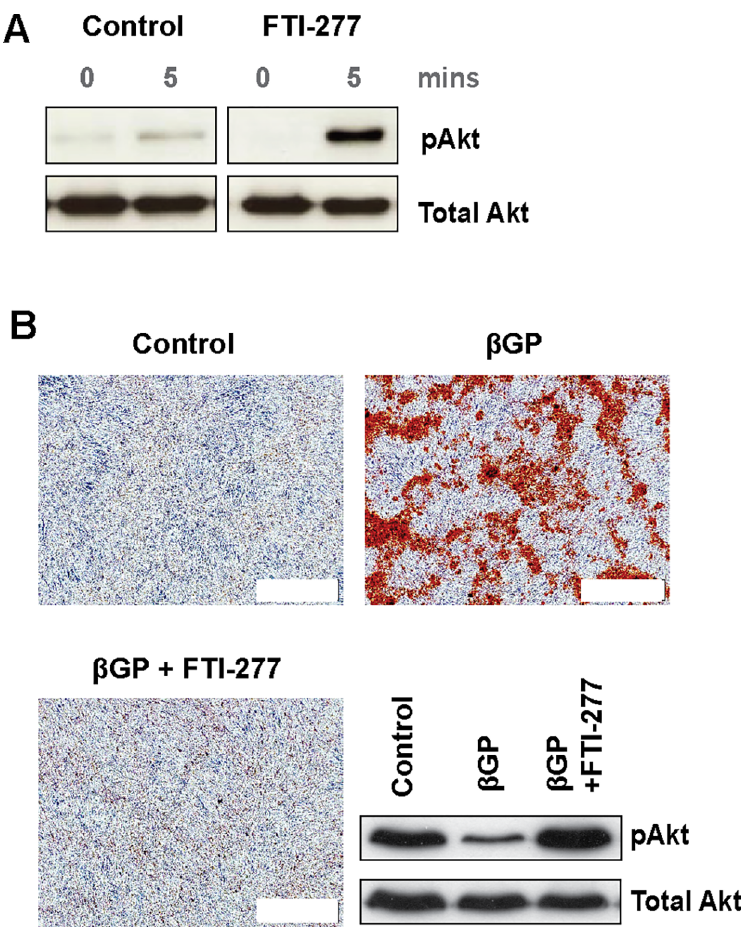
Fig 2. FTI-277 induces Akt signaling in VSMC. ( A ) VSMCs were incubated in 10% FCS-DMEM ± FTI-277 (10 μM) for 77 hours, in serum-free medium ± FTI-277 for 2 hours, and 10% FCS-DMEM for 5 minutes. Cell lysates were collected and analyzed for pAkt and total Akt by western blotting. ( B ) VSMCs were incubated in 10% FCS-DMEM containing DMSO (1:1000), or β GP (5 mM) ± FTI-277 (10 μM) for 10 days. Representative phase contrast images of alizarin red stained cells (white scale bar = 500 μm) and western blots of cell lysates for pAkt and total Akt are shown.